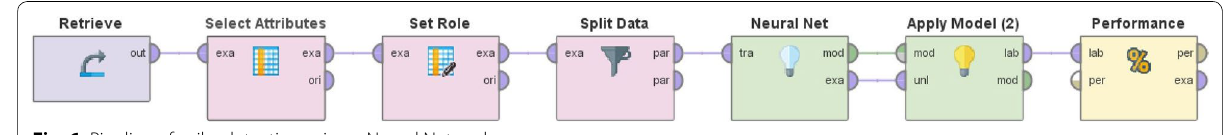
Fig. 6 Pipeline of spike detection using a Neural Network